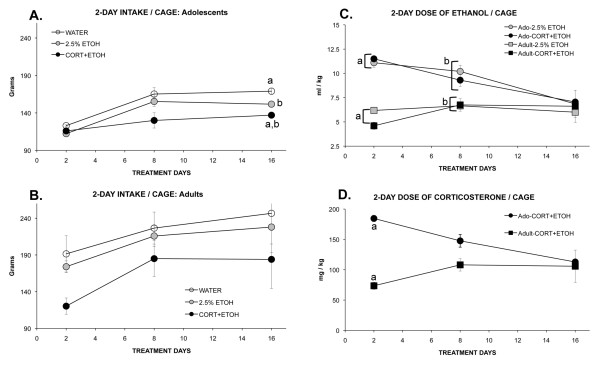
Mean (SEM) intake of fluid in grams in 2 days per pair of rats during 16 days of treatment for rats ingesting corticosterone dissolved in 2.5% ethanol (CORT-ETOH), 2.5% ethanol (ETOH), or water (WATER) as adolescents (a) or as adults (b). (c) Shows the dose of ethanol consumed by body weight and (d) provides the dose of corticosterone consumed by body weight. Matched letters indicate significant (P < 0.05) differences between groups on a treatment day. The main effect of treatment day was significant in (b), in (c) for adolescents only, and in (d) for both adolescents and adults, although in opposite directions (all P < 0.05).